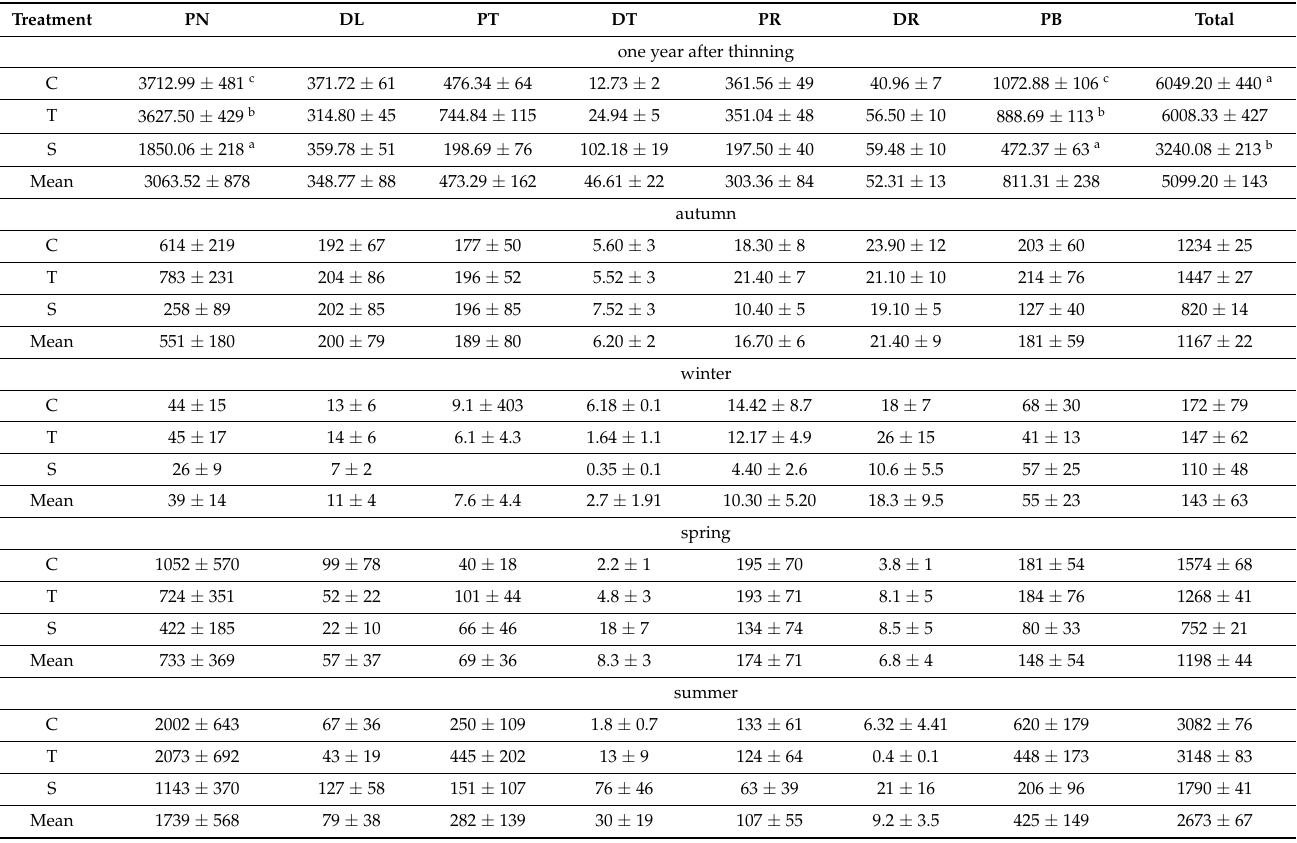
Table 3. Mean cumulative litterfall production for each fraction and total (mean ± SD) expressed as kg · ha − 1 of three replicates for three thinning treatments during four seasons in the study period (16 October until 17 September) (C: Control, T: Traditional. S: Selective, PN: pine needles, DL: deciduous leaves, PT: pine twigs, DT: deciduous twigs, PR: pine reproductive, DR: deciduous reproductive, PB: pine